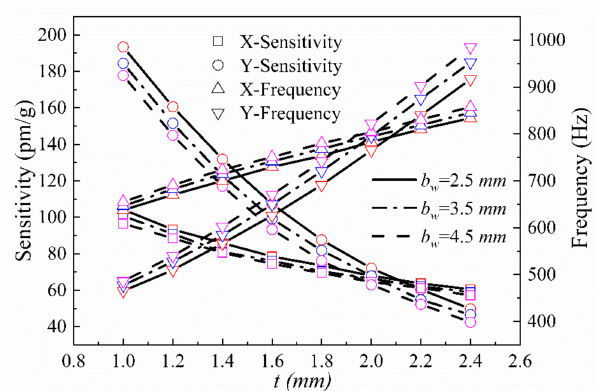
Figure 9. Sensitivities and natural frequencies in the x- and y-directions as a function of t at different values of b t .